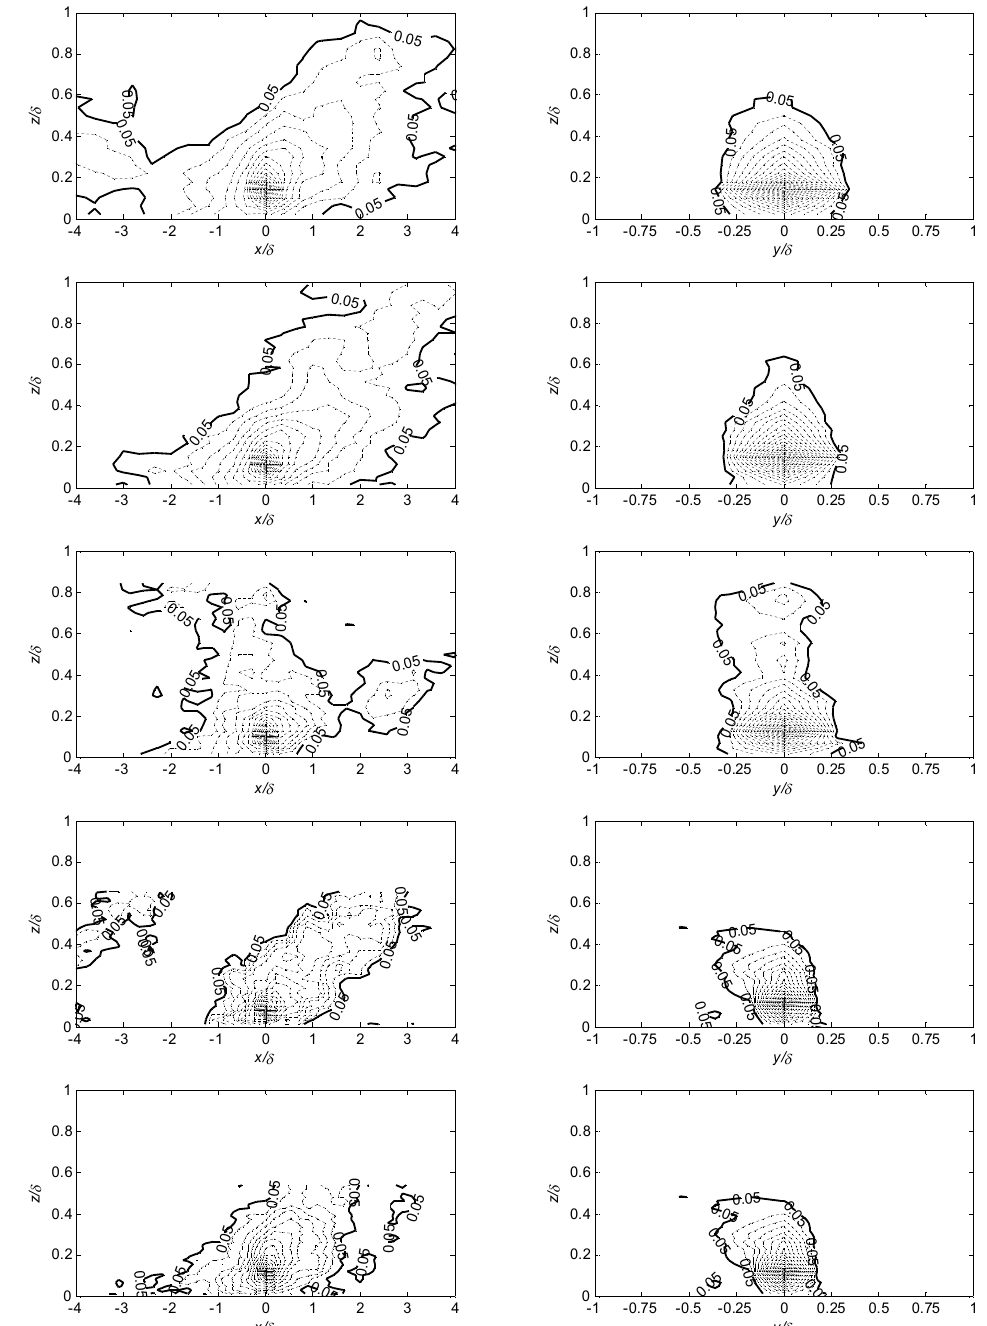
Figure 14. Two-point correlation contours of streamwise-fluctuating velocity.